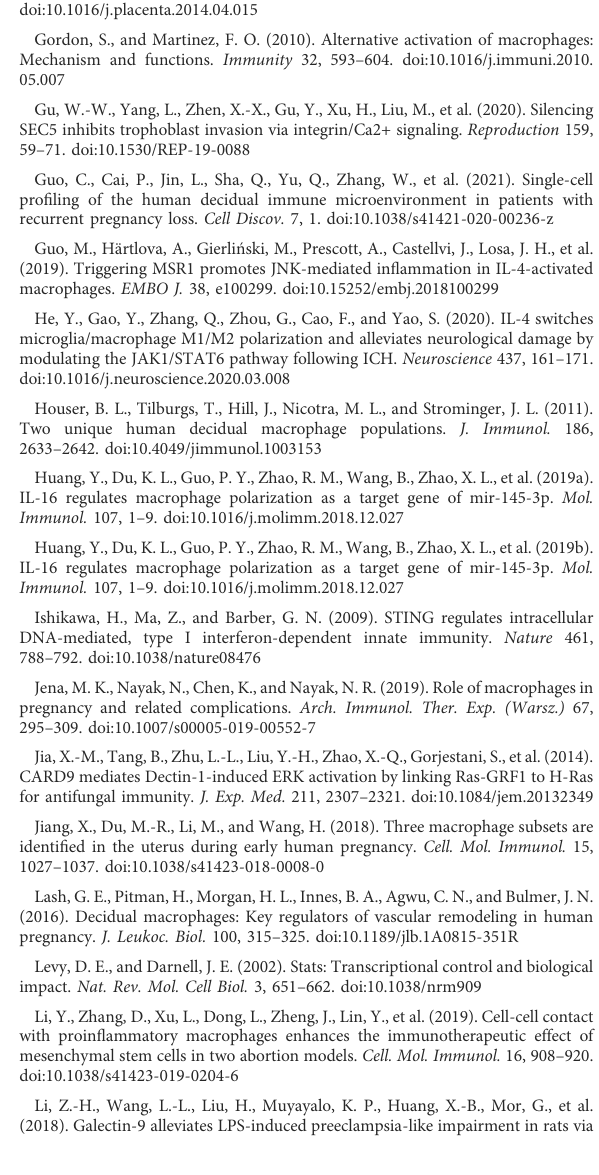
SUPPLEMENTARY FIGURE S3 Genotyping of SEC5 heterozygous mice. Representative images of genotyping via PCR ampli fi cation. Heterozygotes: one band with 460 bp. SUPPLEMENTARY FIGURE S4 Expression levels of SEC5 determined by qRT-PCR in THP-1 Ms and BMDMs stimulated with IL-4 and IL-13 for 24 h. SUPPLEMENTARY FIGURE S5